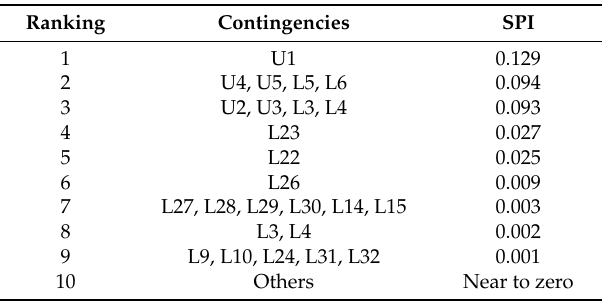
Table 1. SPI values of